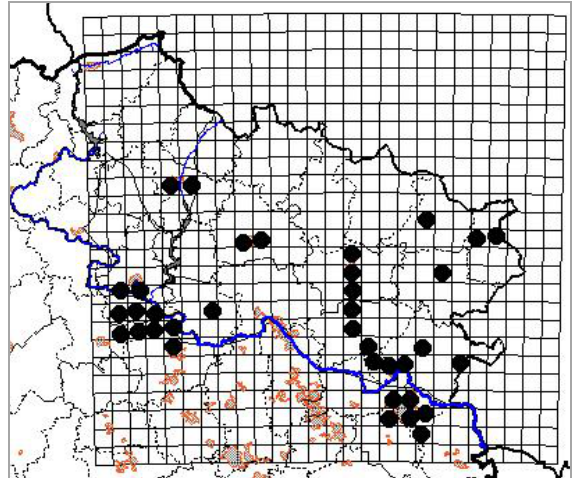
Fig. 28. The map of the distribution of Vicia villosa Roth in the Starobilsk grass-meadow steppe